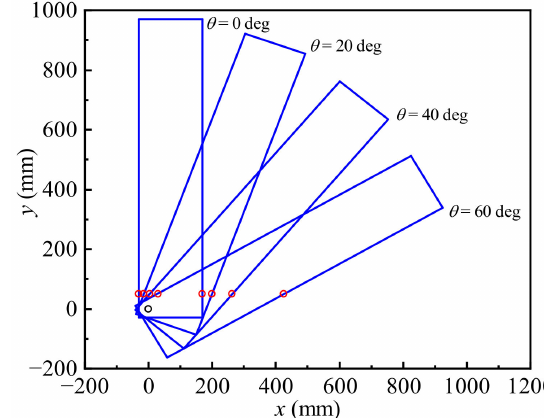
Figure 7. The calculated left boundary points (red circles) of the effective lifting